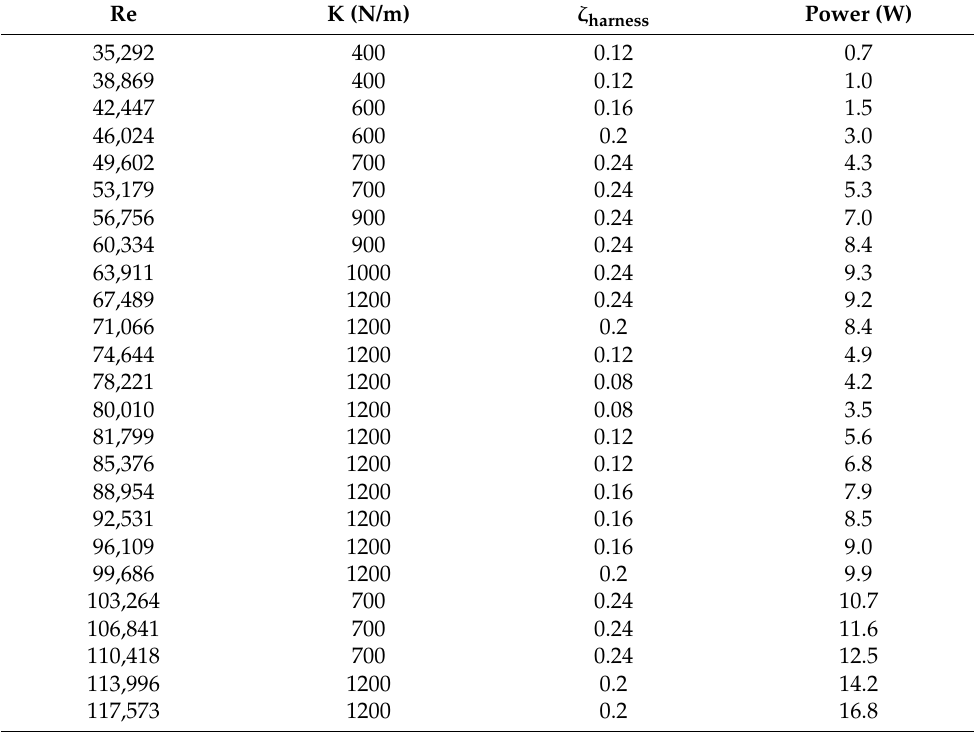
Table 7 lists the optimal power curve values that combine the experimental results of the VIVACE converter with those predicted through deep learning. Table 7. Parameters for optimal harness and converted power curve for combination